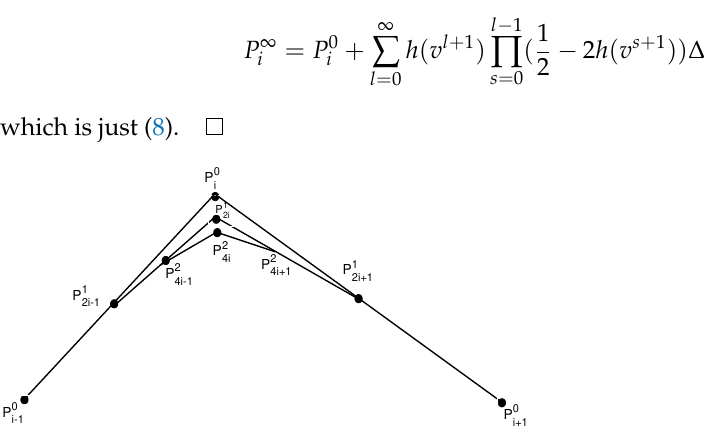
Figure 3. Location of the point P 0